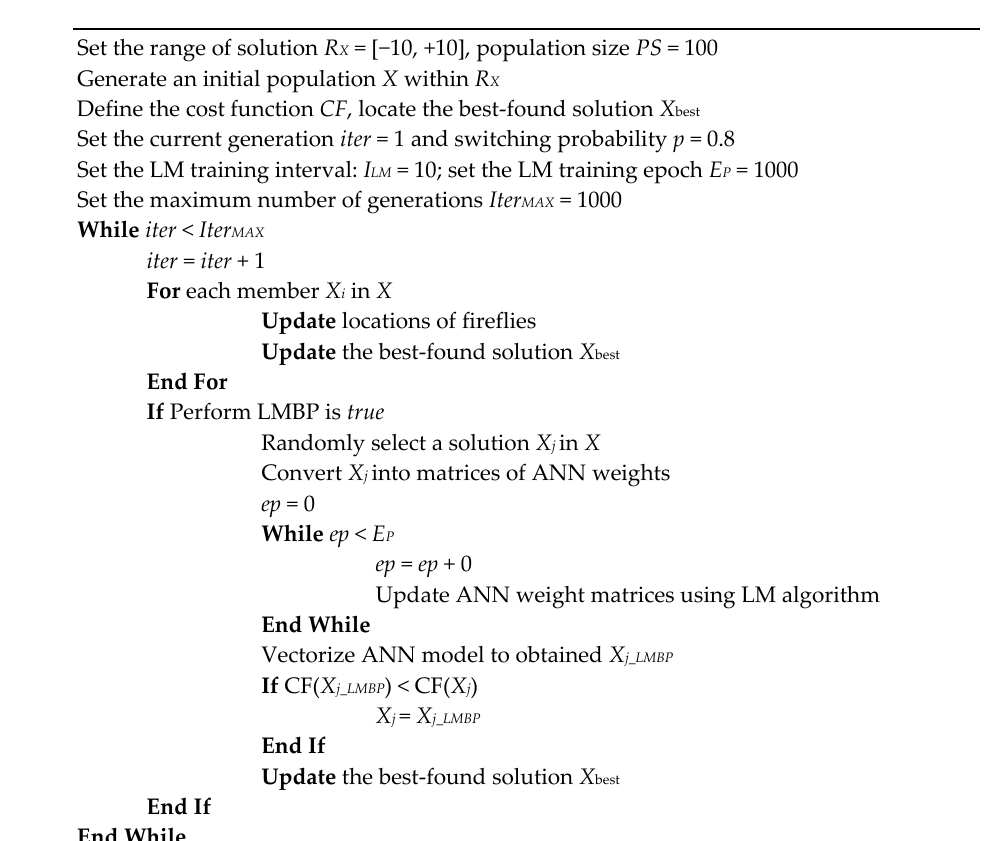
Table 2. Statistical description of the collected data.